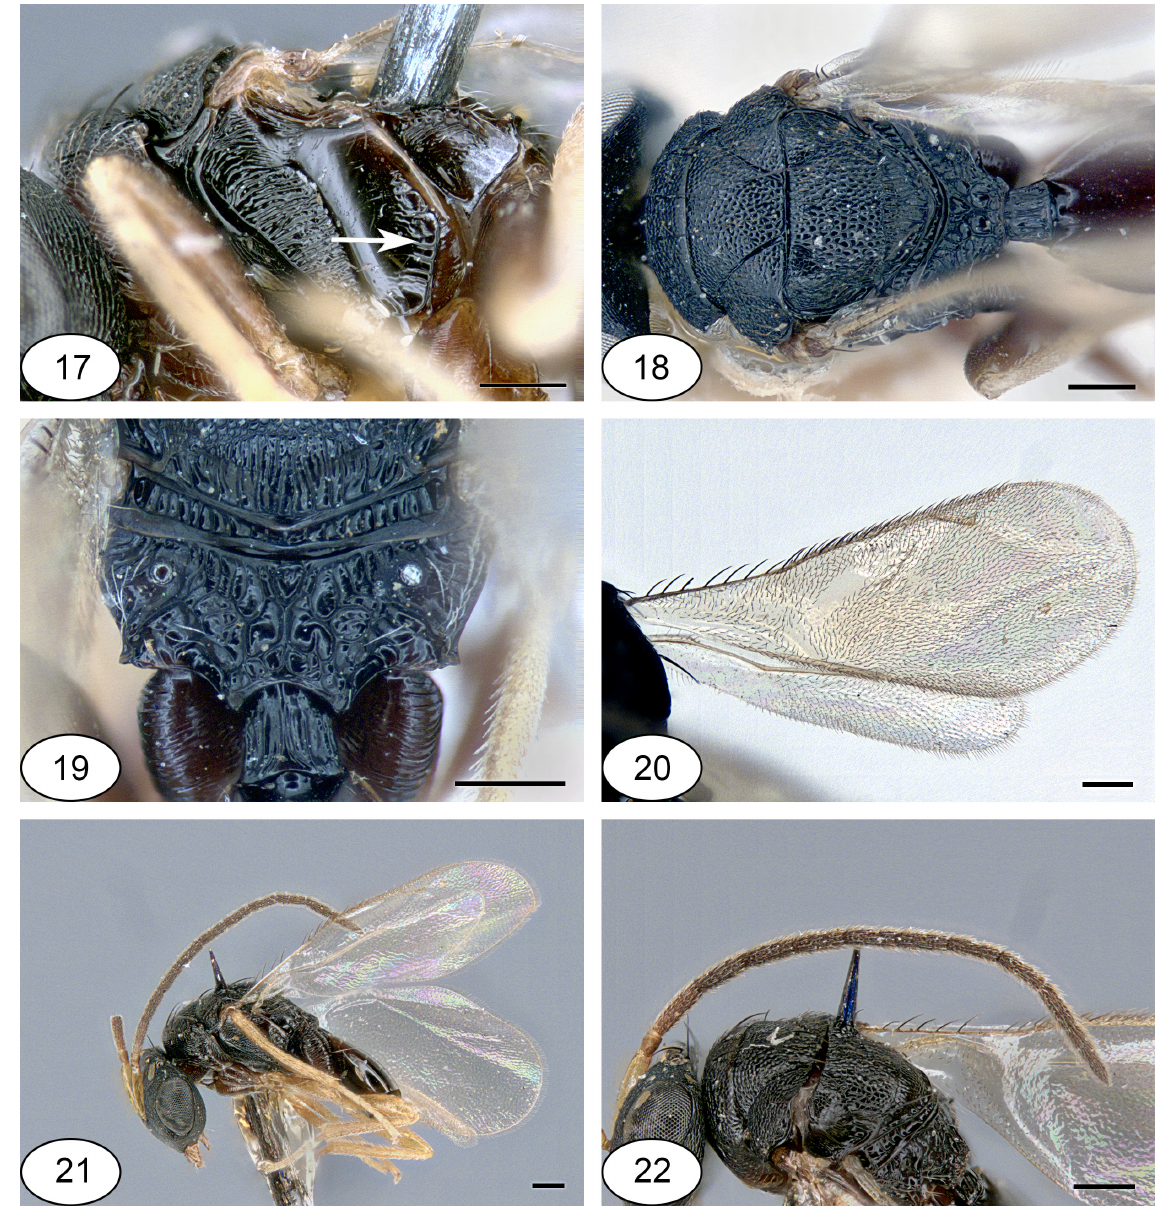
Figs 17–22. Netomocera alboscapus Hedqvist, 1971. 17 . ♀, D.R. Congo, mesosoma, lateral view (mesepimeral sulcus indicated). 18 . Holotype, ♀, mesosoma, dorsal view. 19 . Holotype, ♀, propodeum, dorsal view. 20 . Holotype, ♀, fore and hind wings. 21 . ♂, D.R. Congo, habitus, lateral view. 22 . ♂, D.R. Congo, antenna. Scale bars: 0.2